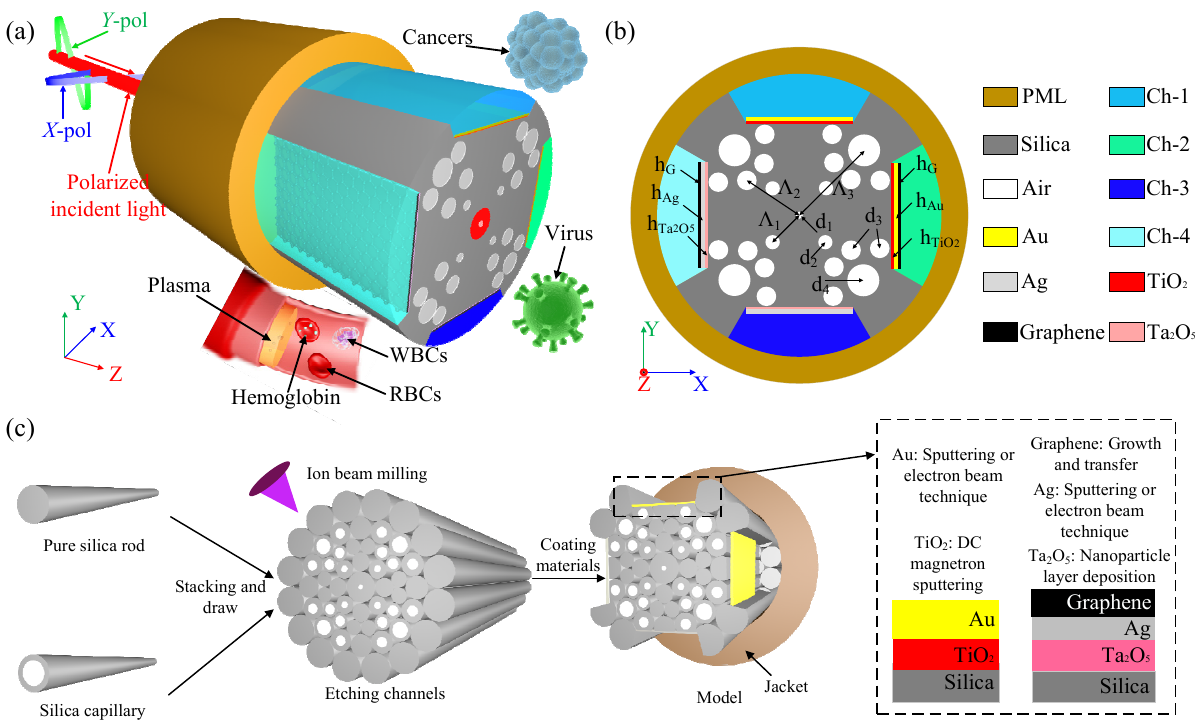
Figure 1. Sensor Model. ( a ) Three-dimensional model; ( b ) Two-dimensional cross-sectional view of the sensor; ( c ) Manufacturing model .